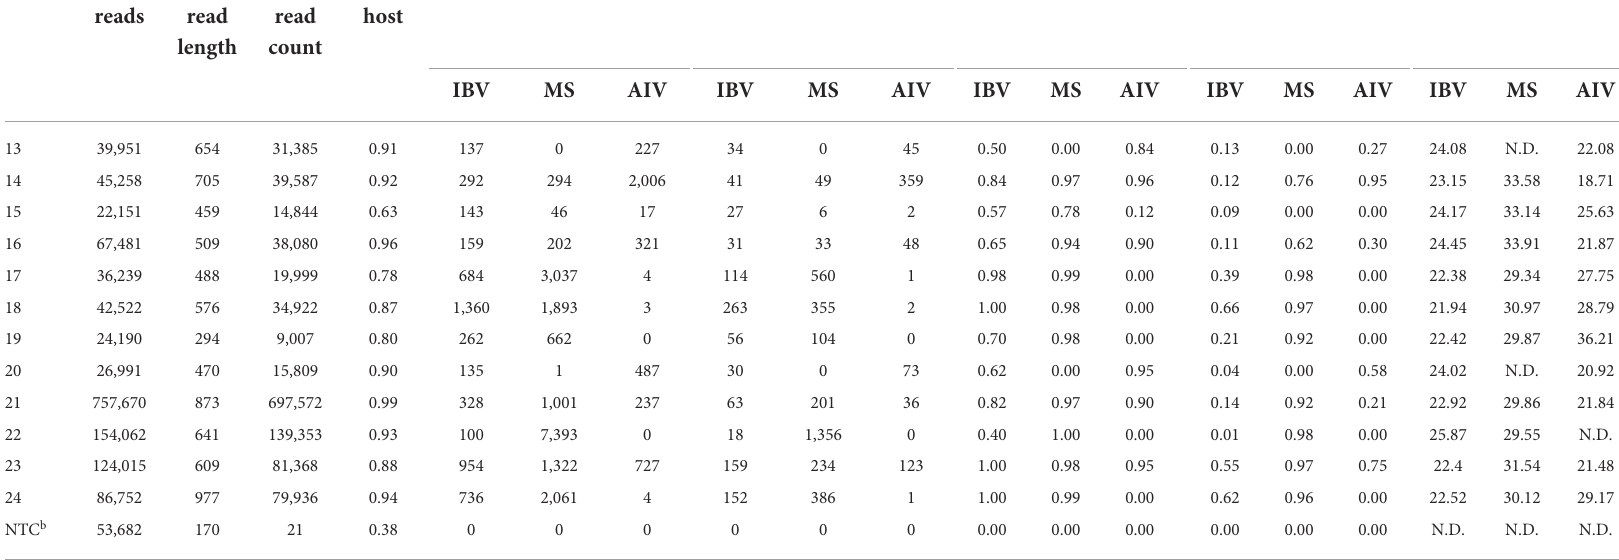
TABLE 2 Microbial reads obtained at different hours (h) from random sequencing using MinION on experimental oropharyngeal swab